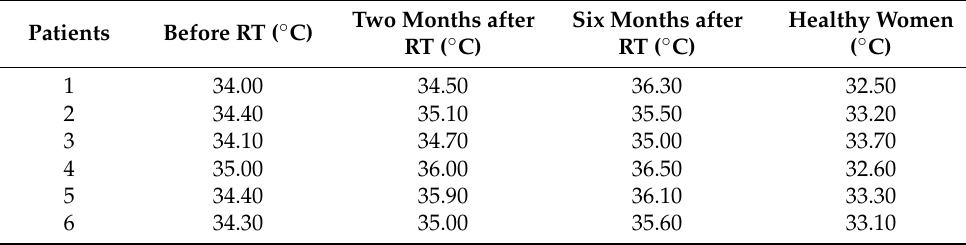
Table 1. Results of breast temperatures for all patients and for the healthy control group. Patients